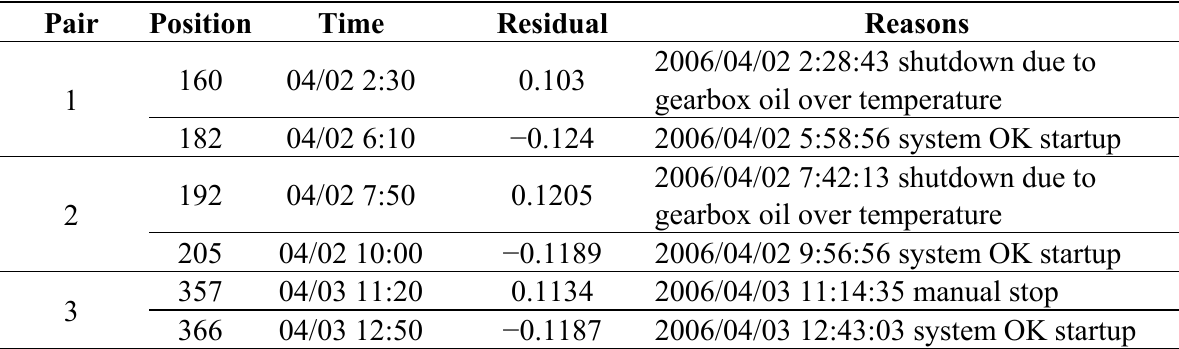
Table 2. Large residuals’ positions and